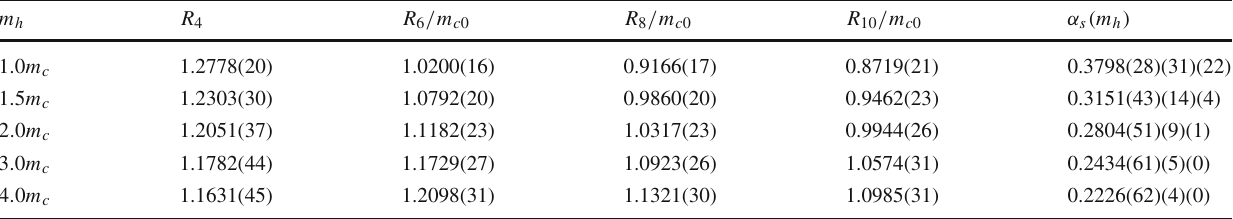
Table1 Thecontinuumresultsforthereducedmomentsofquarkonium errors in α s correspond to the lattice error, the perturbative error, and the error due to the gluon condensate, respectively, see text correlators at different heavy-quark masses. The last column shows the α μ = m s values extracted from R 4 with h . The first, second, and third m h R 4